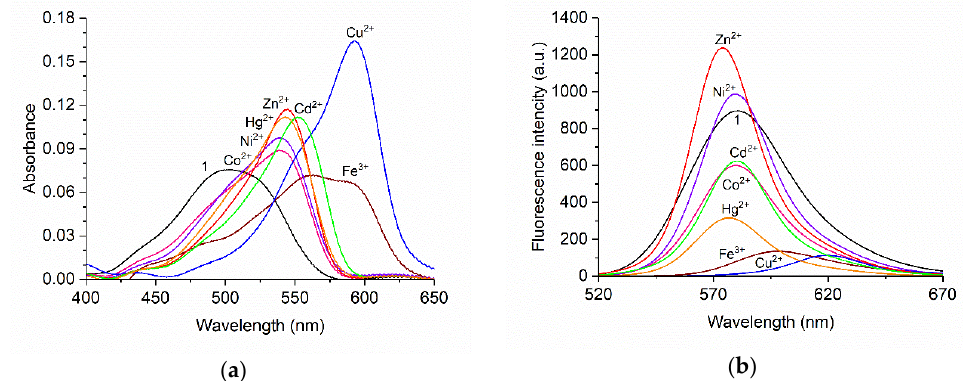
Figure 2. ( a ) Absorption and ( b ) fluorescence spectra of BODIPY 1 (3 µM) in the presence of different metal cations (300 µM) in acetonitrile with excitation at 510 nm.